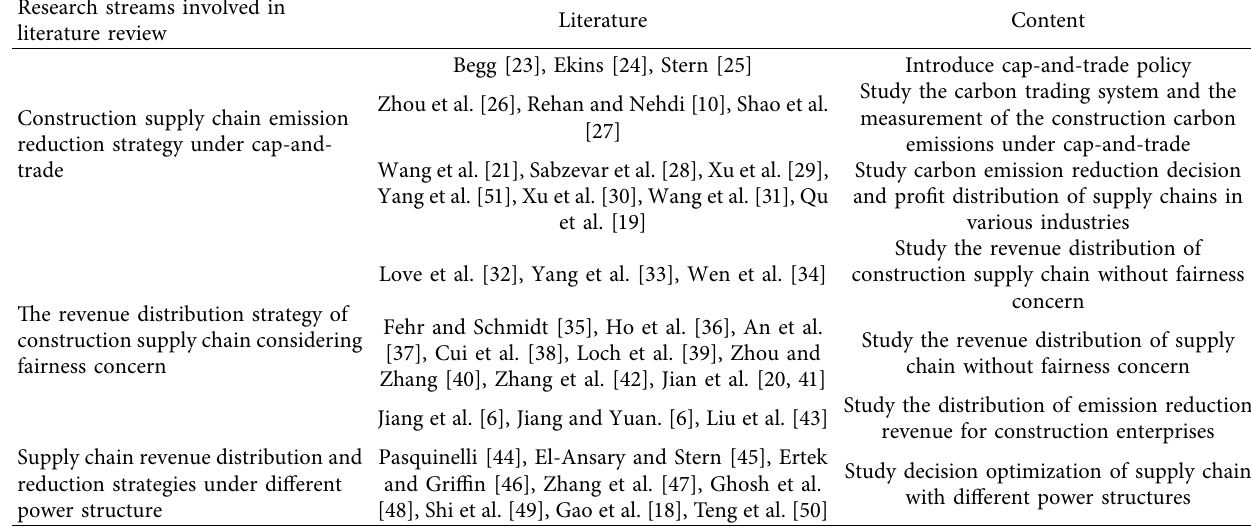
Table 1: Comparative analysis of research